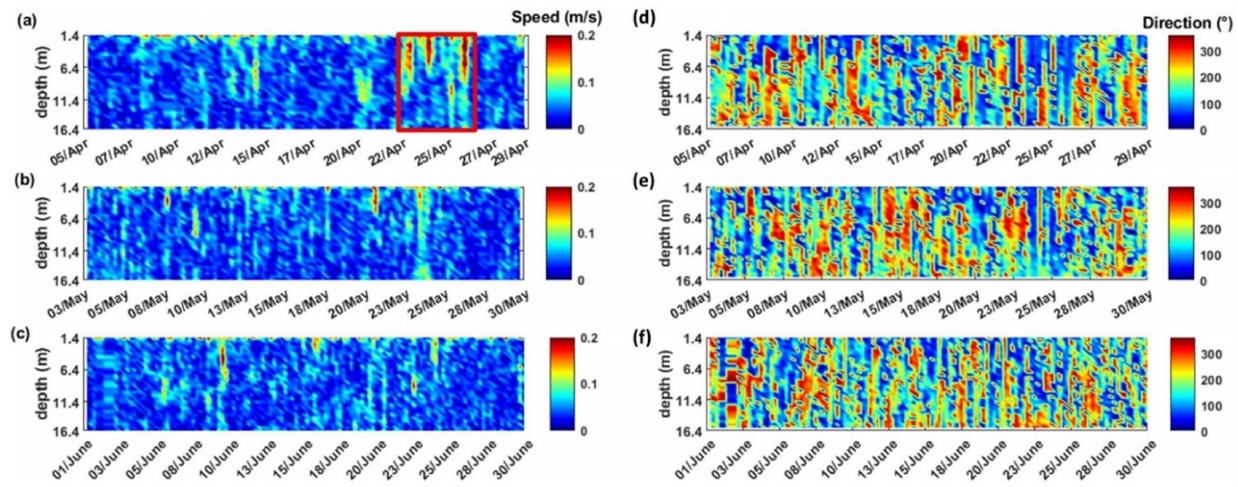
Figure 5. Hovmöller diagrams of sea current intensity ( a – c ) and direction ( d – f ) recorded by the ADCP probe mounted on MEDA B Napoli buoy for April, May and June 2016.